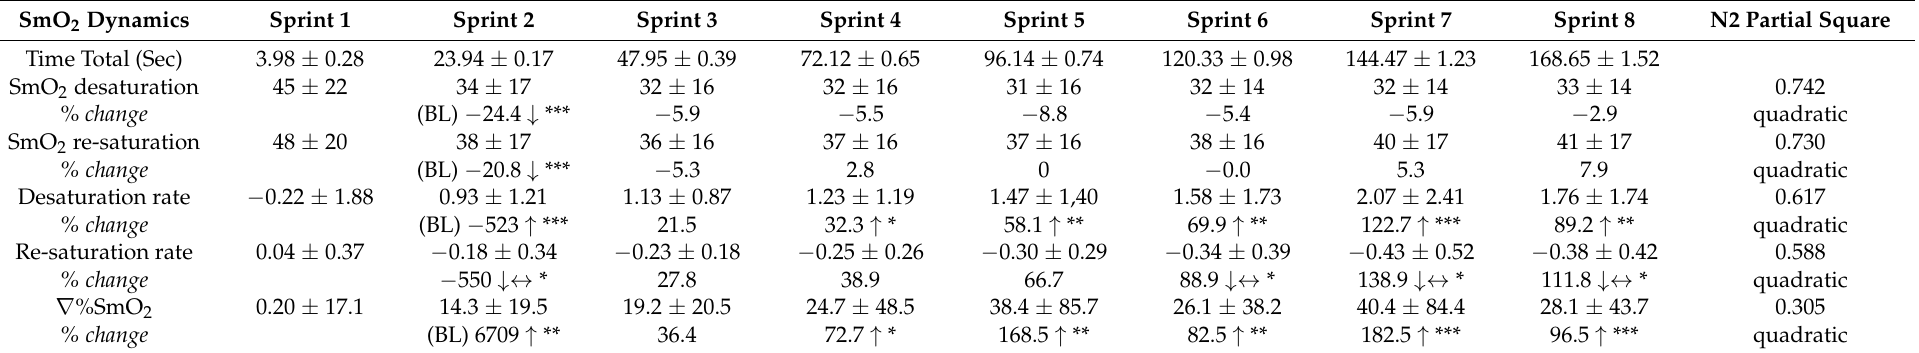
Table 2. Analysis of muscle desaturation and re-saturation during repeated sprint ability in women soccer